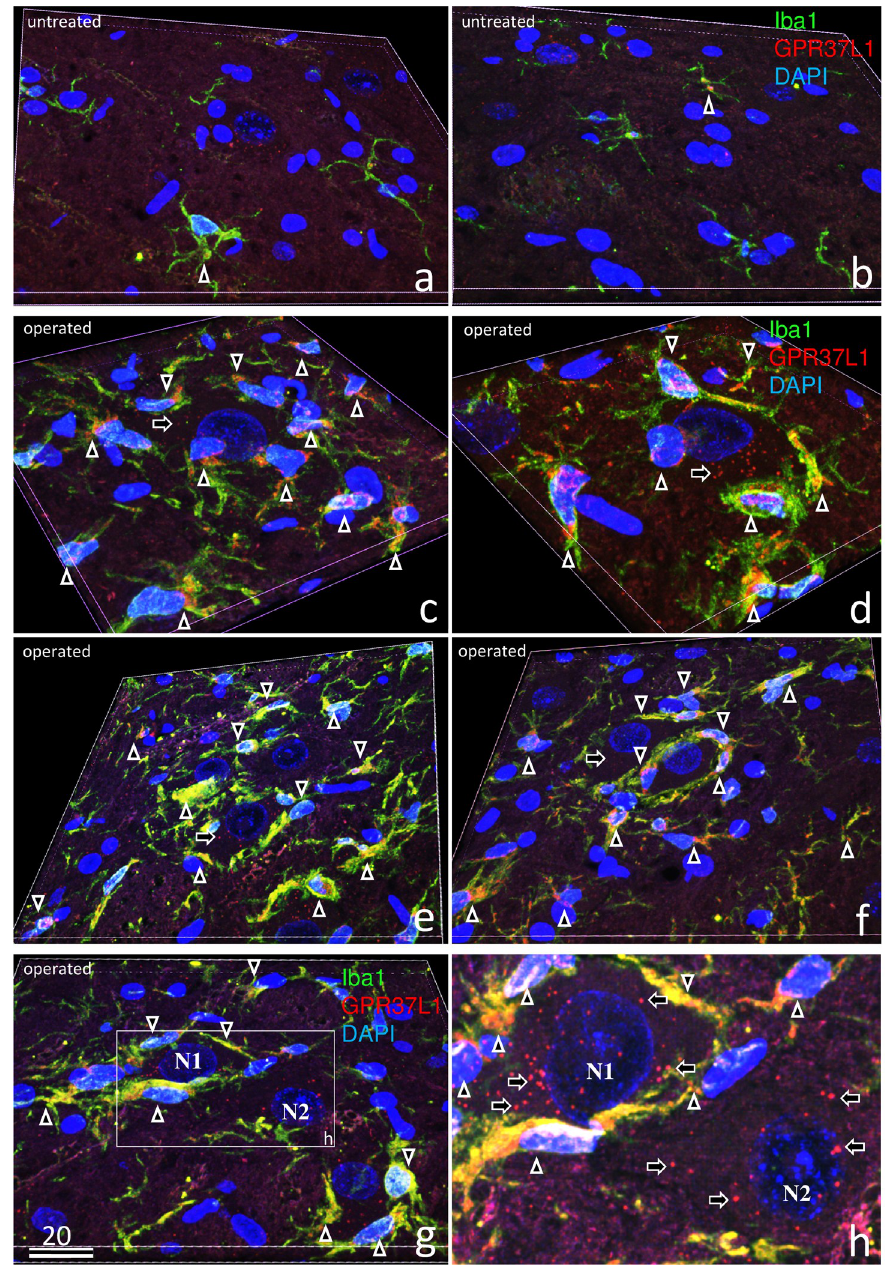
Fig 6. Three-dimensional laser-scanning confocal analysis of triple-staining with GPR37L1 (red), Iba1 (green), and DAPI (blue) in the untreated (a, b) and operated sides (c–h) of the facial nucleus 7 days after facial nerve transection. On the untreated side (a, b), there were far fewer microglia than on the operated side, and co-localization of GPR37L1 with Iba1 was rare (arrows in a, b). In contrast, a strong GPR37L1-IR signal (arrows) was observed in the cell bodies of big motoneurons (c, d), small neurons (e, f), and many microglia (c–h). Some microglia gathered around neurons (c), two microglia extended their processes around neurons (d), and some microglia completely covered the neurons (e, f). One neuron (N1 in g, h) was completely covered by many microglia, but the other neighboring neuron (N2 in g, h) was not covered with any microglia. The numbers on the bars indicate the scale in microns.